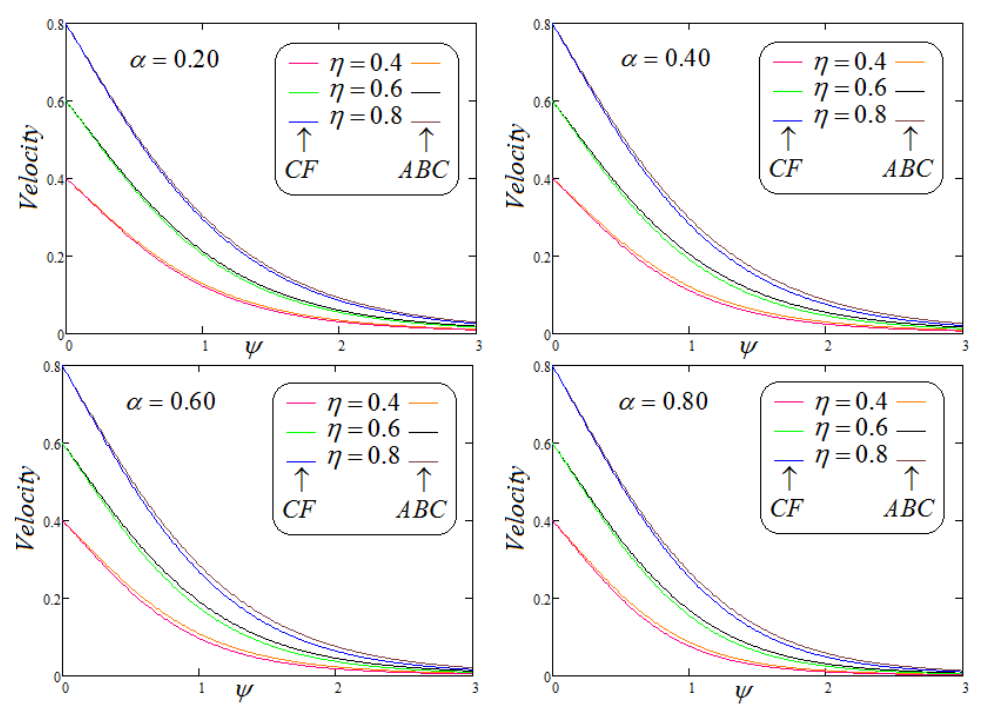
Figure 13. Comparison of dimensionless velocity profil for dissimilar values of η between CF and